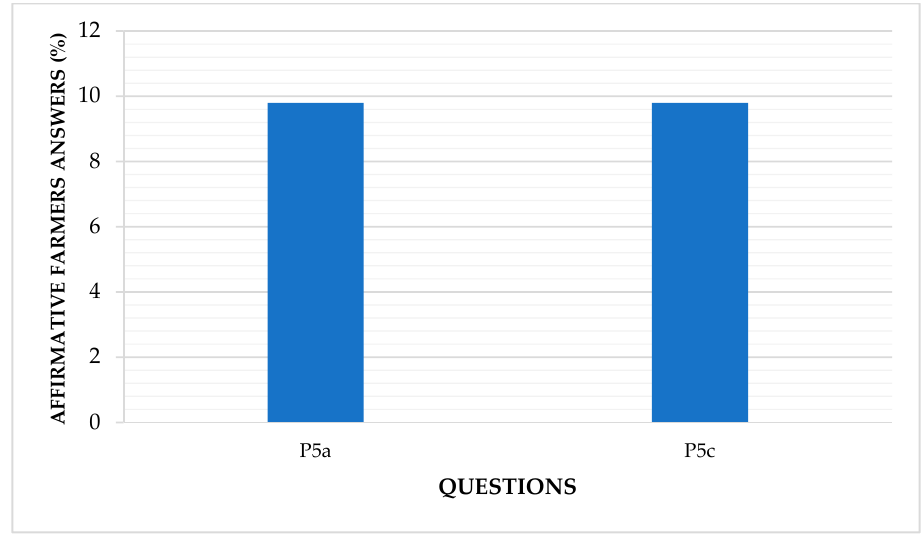
Figure 10. Answers for questions in Block 4 (farmers).